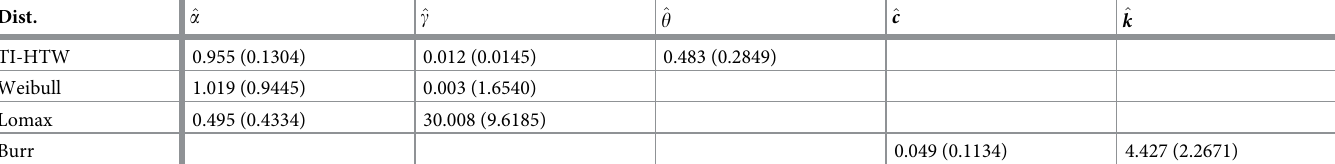
Table 11. Maximum likelihood estimates of the fitted models with standard error (in parenthesis) for data 3. Dist.